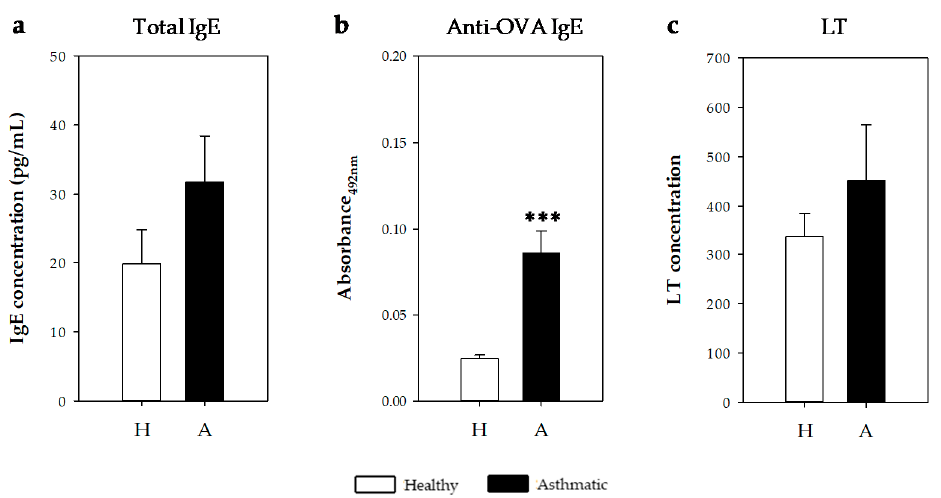
Figure 6. ( a ) Total and ( b ) anti-OVA IgE concentrations and ( c ) CysLT content in bronchoalveolar lavage fluid (BALF) samples obtained 24 h after the i.n. challenge in healthy (H, white bars) and asthmatic rats (A, black bars). Results are expressed as mean ± standard error (N = 9). Significant differences: *** p < 0.001 vs. healthy animals.